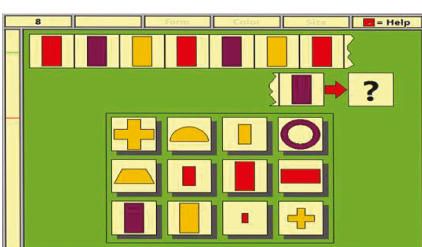
Figure 8: Example of training on level 8, on the logical reasoning RehaCom module.